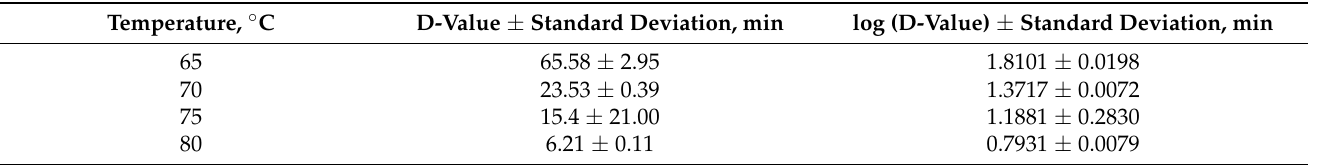
Table 5. Decimal reduction times (D-values) obtained from the thermal destruction of Salmonella spp. in animal feed treated at different temperatures. Temperature, ◦